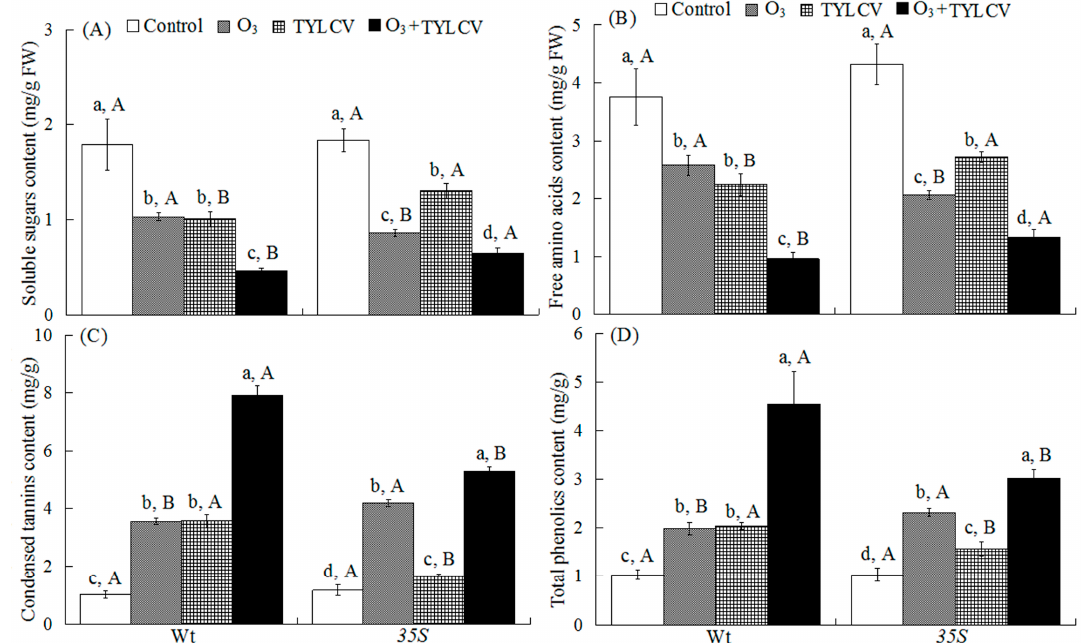
Figure 2. Concentrations of soluble sugars ( A ); free amino acids ( B ); condensed tannins ( C ); and total phenolics ( D ) in the two tomato genotypes (Wt and 35S ) grown under ambient and elevated O 3 with and without TYLCV infection after six weeks. Treatments are explained in Figure 1. Each value represents the average (±SE) of four replicates. Different lowercase letters within a row indicate significant differences among the four treatments in a specific tomato cultivar, and different uppercase letters indicate significant differences between tomato genotypes within the same treatment (Tukey’s test: p < 0.05).